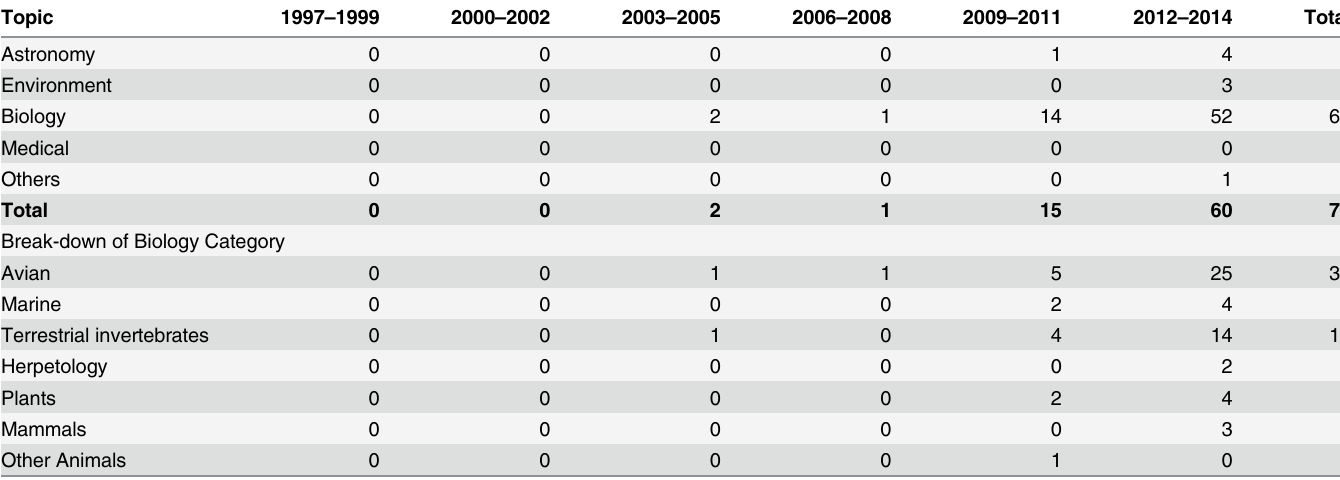
Table 4. The number articles acknowledging the use of citizen science data from past projects grouped by topic from 1997 to 2014.